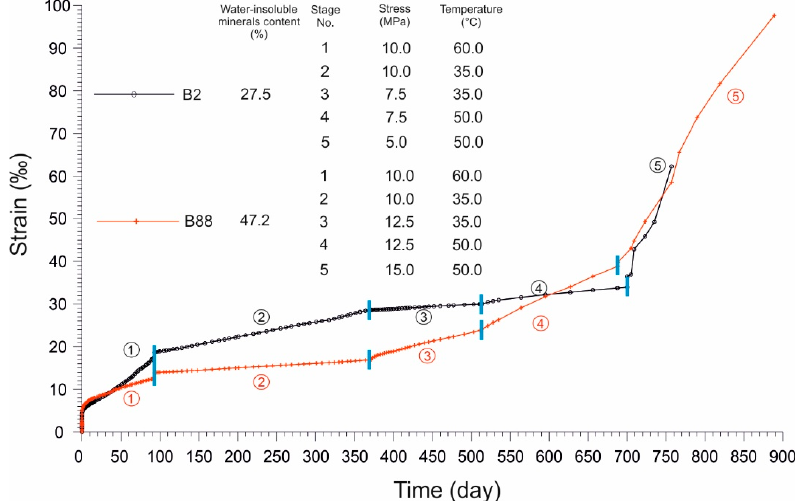
Figure 18. Long-term creep curves of the Brown Zuber unit samples at changing stress and temperature conditions (according to